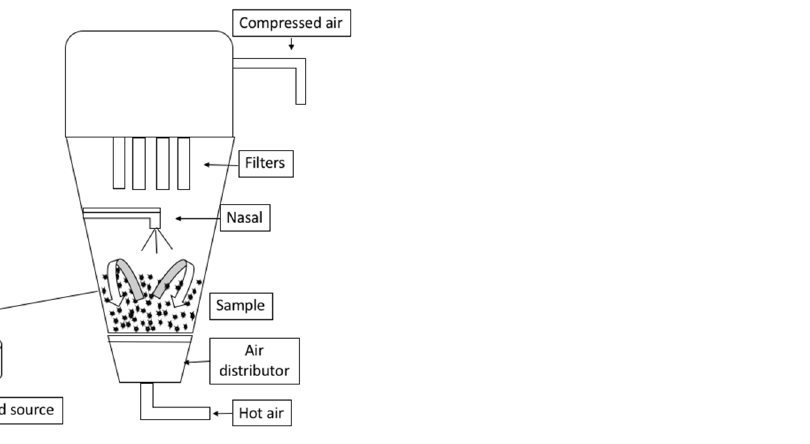
Figure 1. The top-spray fluid bed granulator (Midi-Glatt) that was used in agglomerating WPI pow- der.